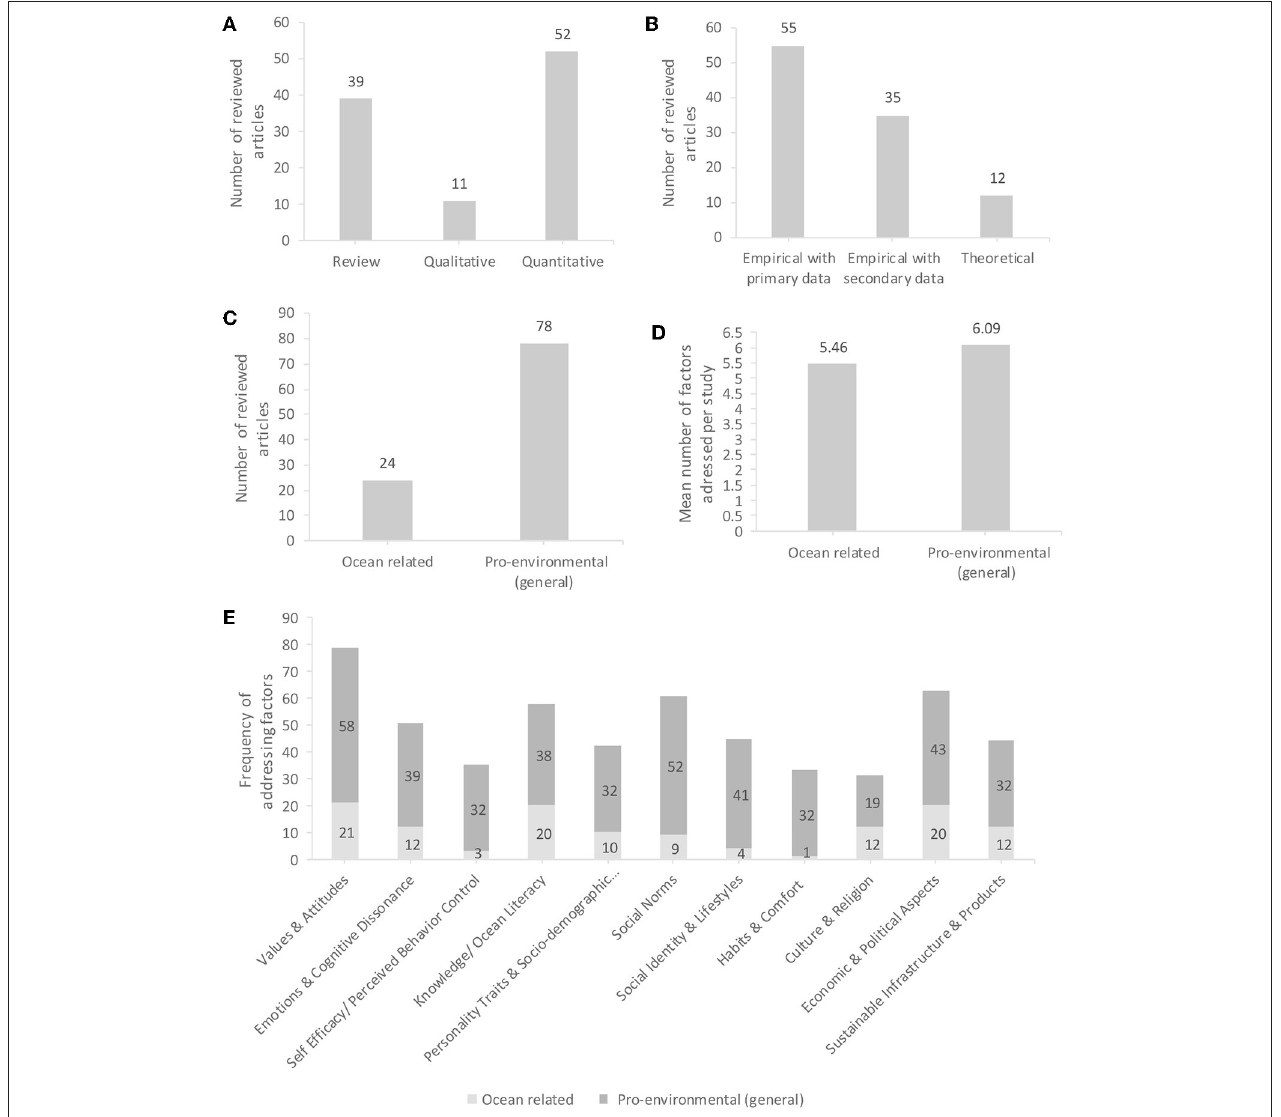
FIGURE 2 | (A) Total number of articles reviewed according to their approach. (B) Total number of articles reviewed according to their data background. (C) Number of studies reviewed according to the category of behavior addressed. (D) Mean number of factors addressed per reviewed study. (E) Frequency of cited factors regarded as most influencing patterns of ocean related and general pro-environmental behavior, additionally divided according to the category of behavior addressed in the respective study (one article can consider more than one category; left: personal factors, right: socio-cultural and other external factors). See text for full